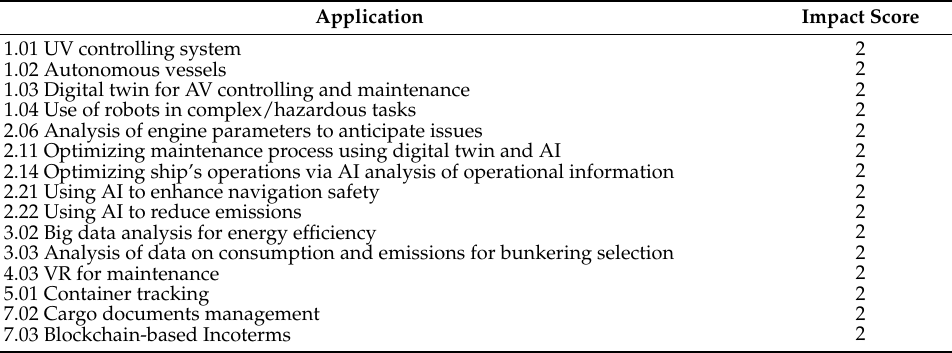
Table 10. Top applications on Quality performance dimension.